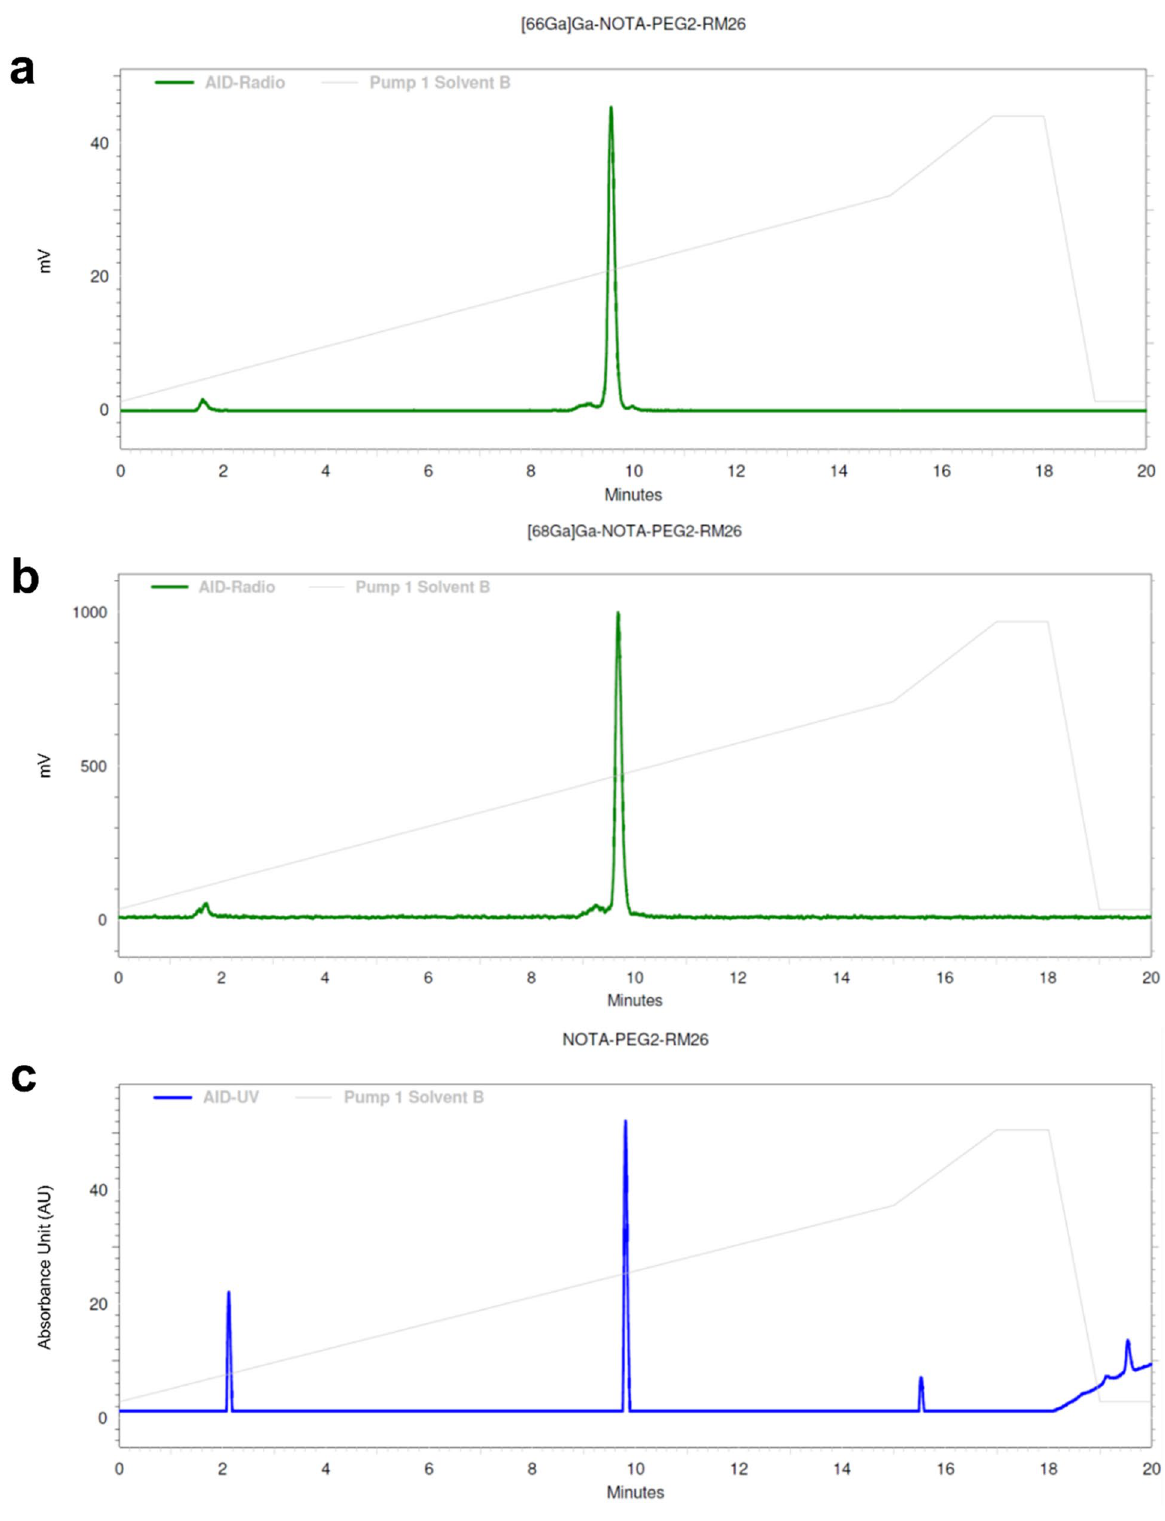
Figure 1. HPLC chromatograms of (a) [ 66 Ga]Ga-NOTA-PEG 2 -RM26, (b) [ 68 Ga]Ga-NOTA-PEG 2 -RM26 and (c) NOTA-PEG 2 -RM26. HPLC analysis was done using a C18 column and a gradient of 5 to 70% acetonitrile (with 0.1% TFA) in water over 15